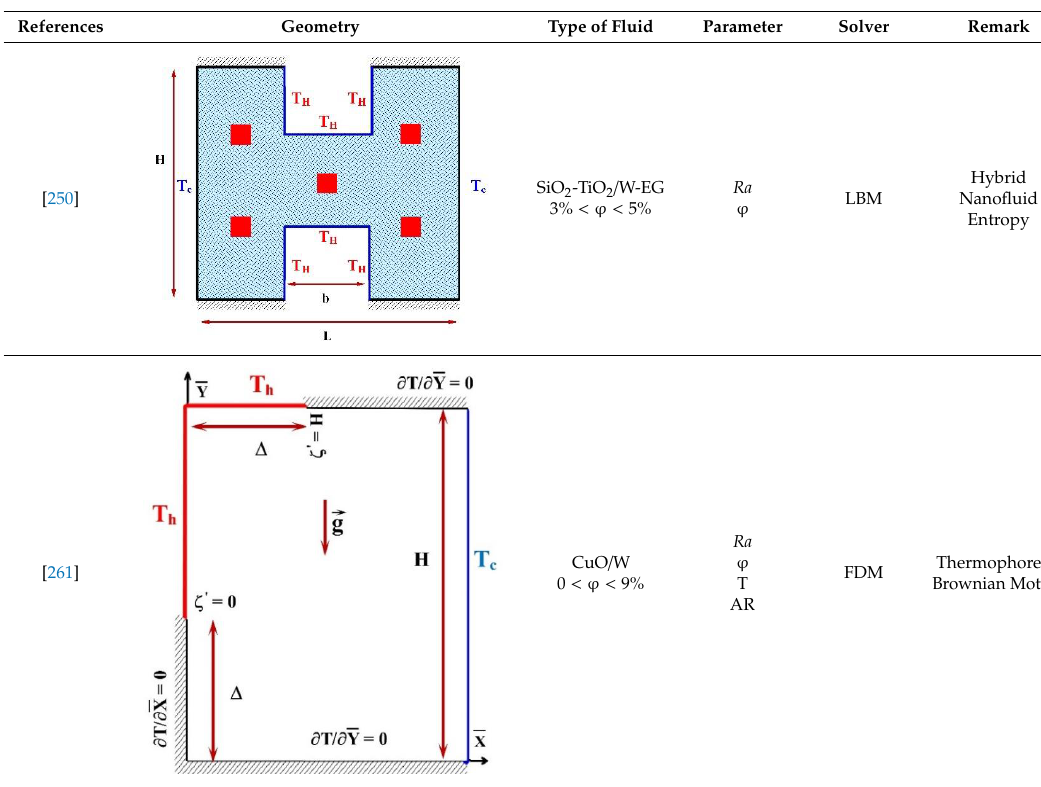
Table 14. Summarizing papers along with their figures.